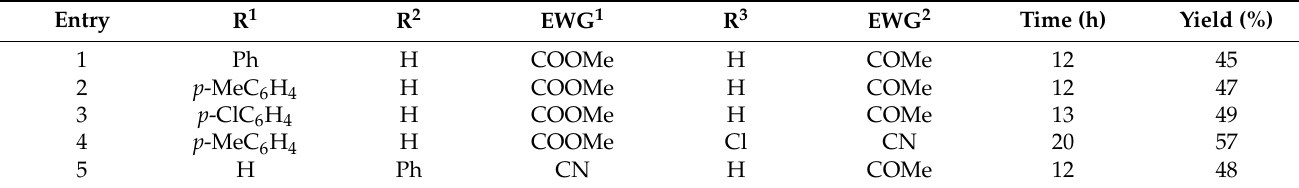
(Table 14). The reaction could be applied to tethered α , β -unsaturated esters, ketones, and aldehydes, and both E- and Z -alkenes were found to give the same major diastereomer of the